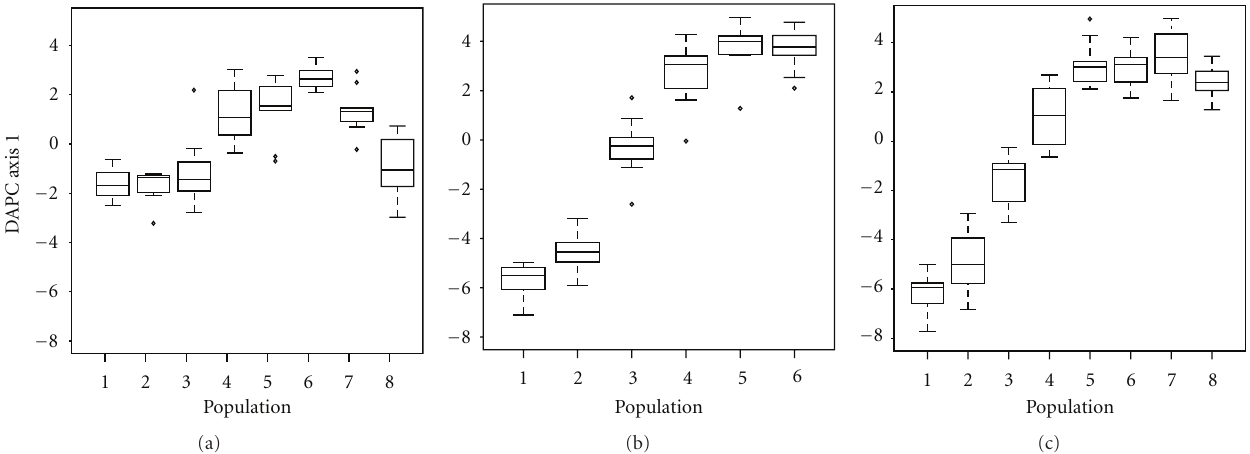
Figure 3: DAPC (discriminant analysis of principal components) based on the combination of genetic and quantitative trait characters (see supplementary Figure S1 available online at doi: 10.1155/2012/273413 for the separate